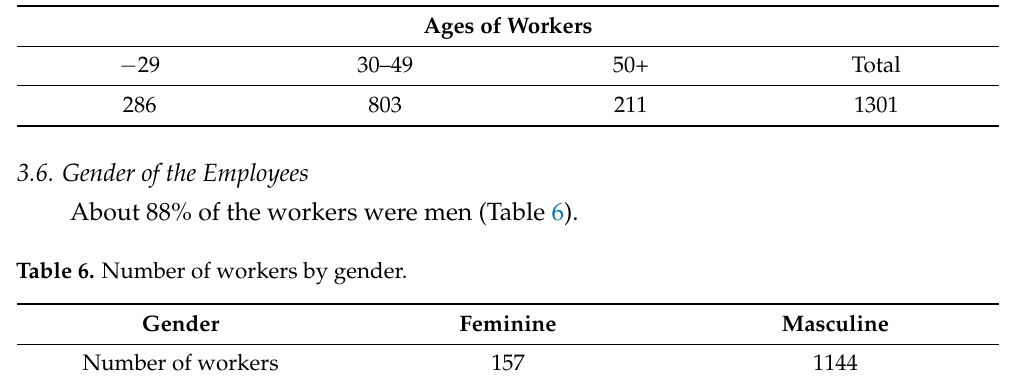
Table 5. Distribution of ages.